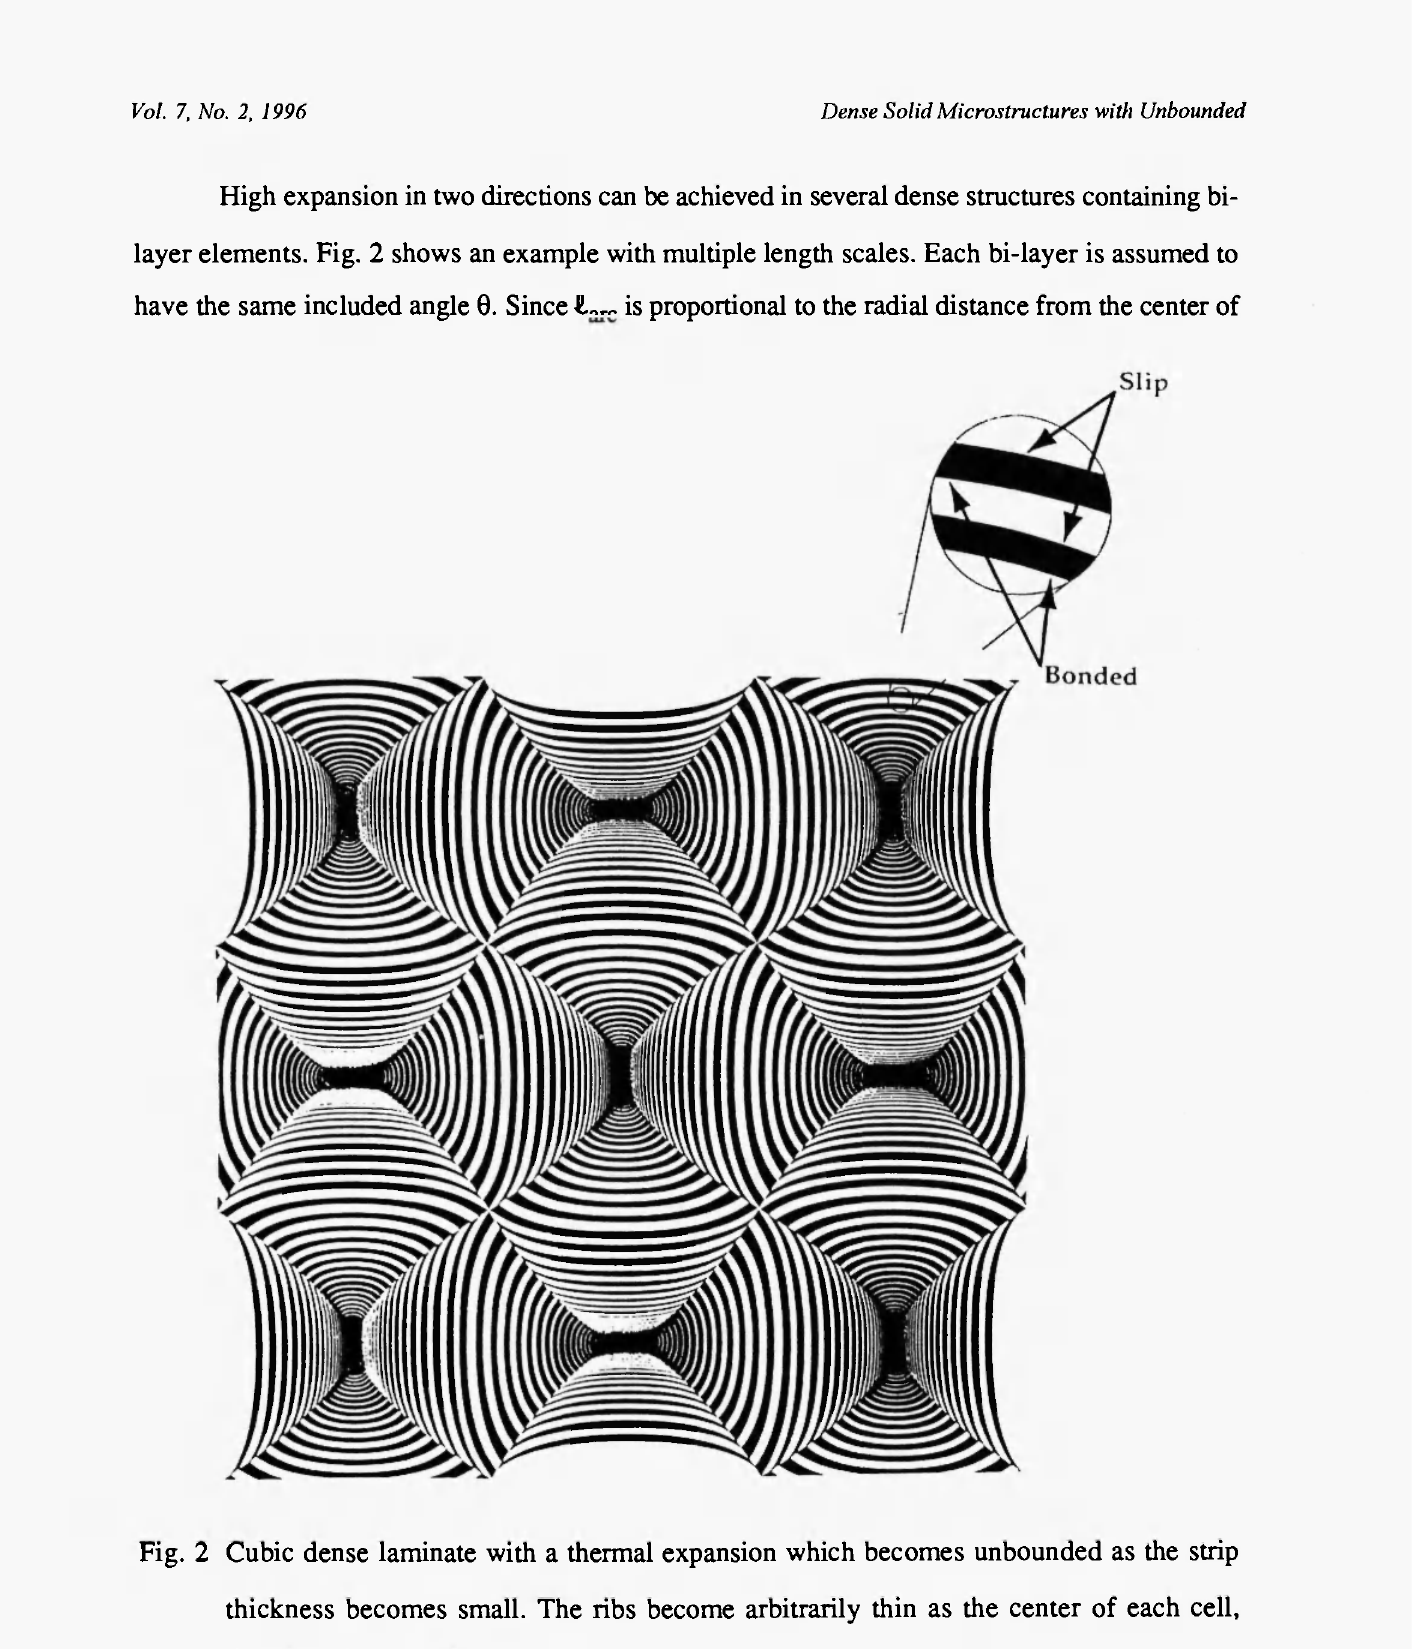
Fig. 2 Cubic dense laminate with a thermal expansion which becomes unbounded as the strip thickness becomes small. The ribs become arbitrarily thin as the center of each cell, therefore the center is not